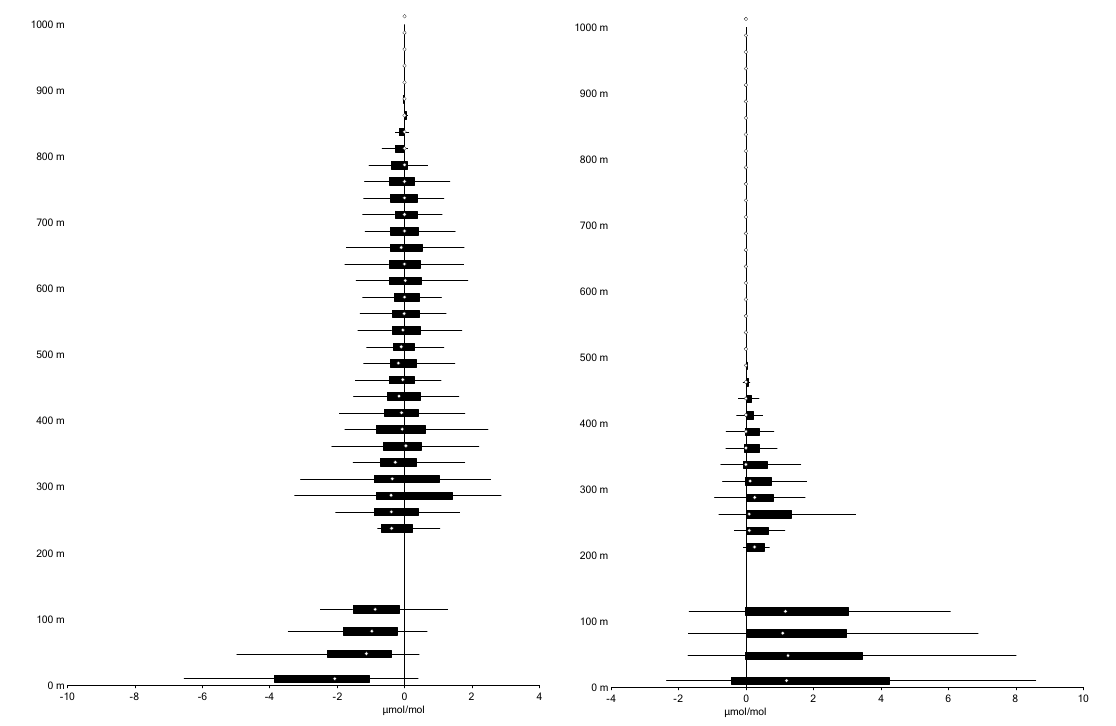
Figure 2. Empirical frequency distribution of the differences between the CO 2 mole fraction measured at the top of a tower of a given height (tower height) simulated by the aircraft or the existing tower and the mid-PBL CO 2 mole fraction determined from the aircraft vertical profiles for summer (left) and winter (right). Whiskers represent the lowest value still within the 1.5 interquartile range (IQR) of the lower quartile and the highest value still within 1.5 IQR of the upper